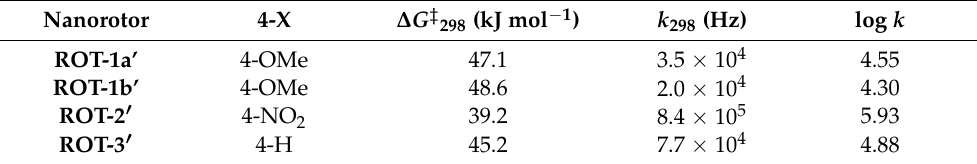
Table 2. Experimental rotational frequency and activation barriers at 25 ◦ C, as calculated from VT 1 H